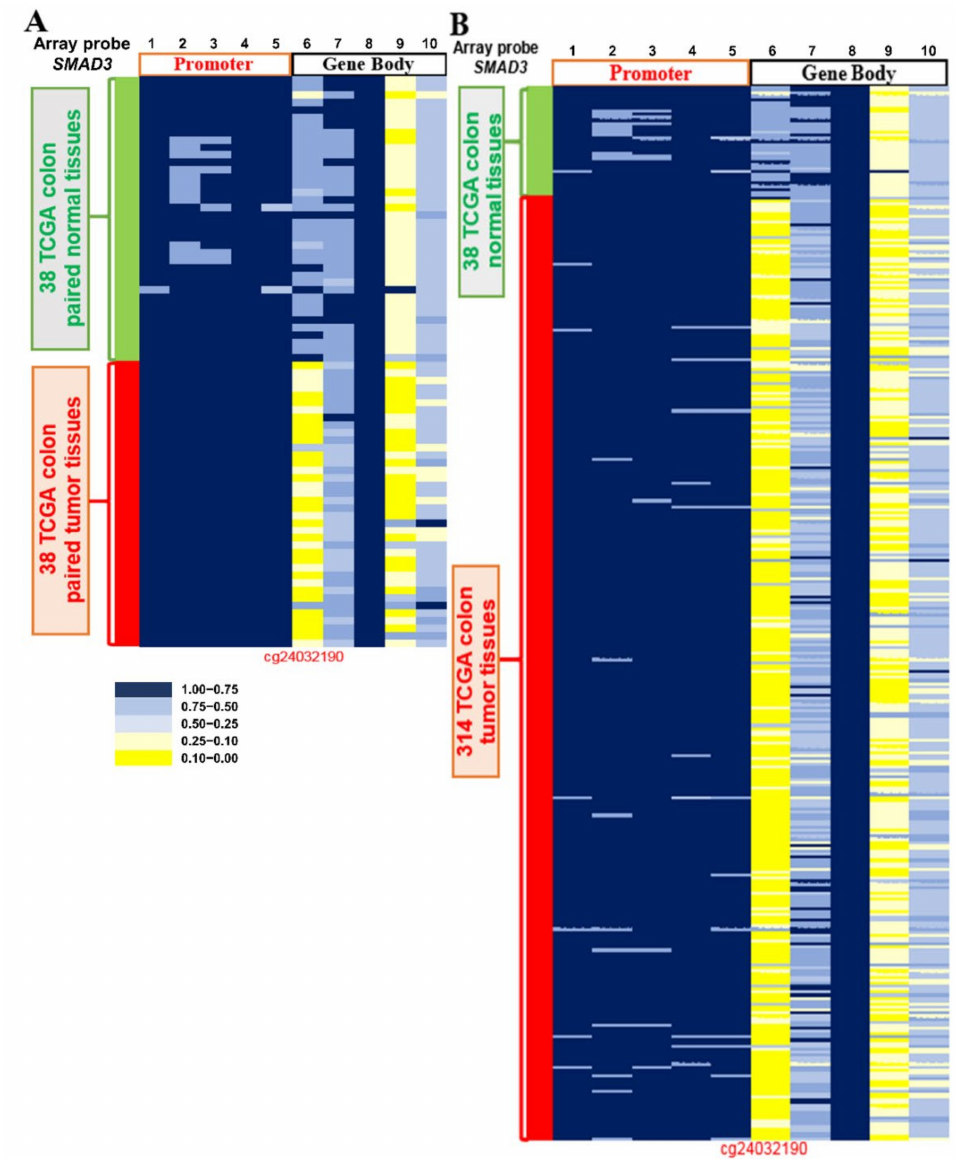
Figure 3. SMAD3 DNA methylation analysis from The Cancer Genome Atlas dataset. Di ff erentially methylated CpG sites in SMAD3 were identified in ( A ) 38 adjacent normal colorectal tissues, 38 matched colorectal carcinoma (CRC) tumors, and ( B ) 314 CRC tumors by using an Illumina Human Methylation 450K array-based assay. The five CpG sites in promoter regions − 1133, − 525, − 413, − 122, and − 94 are designated 1, 2, 3, 4, and 5, respectively. The CpG sites in gene body regions + 12535, + 927, + 11421, + 1331, and + 2511 are designated 6, 7, 8, 9, and 10,